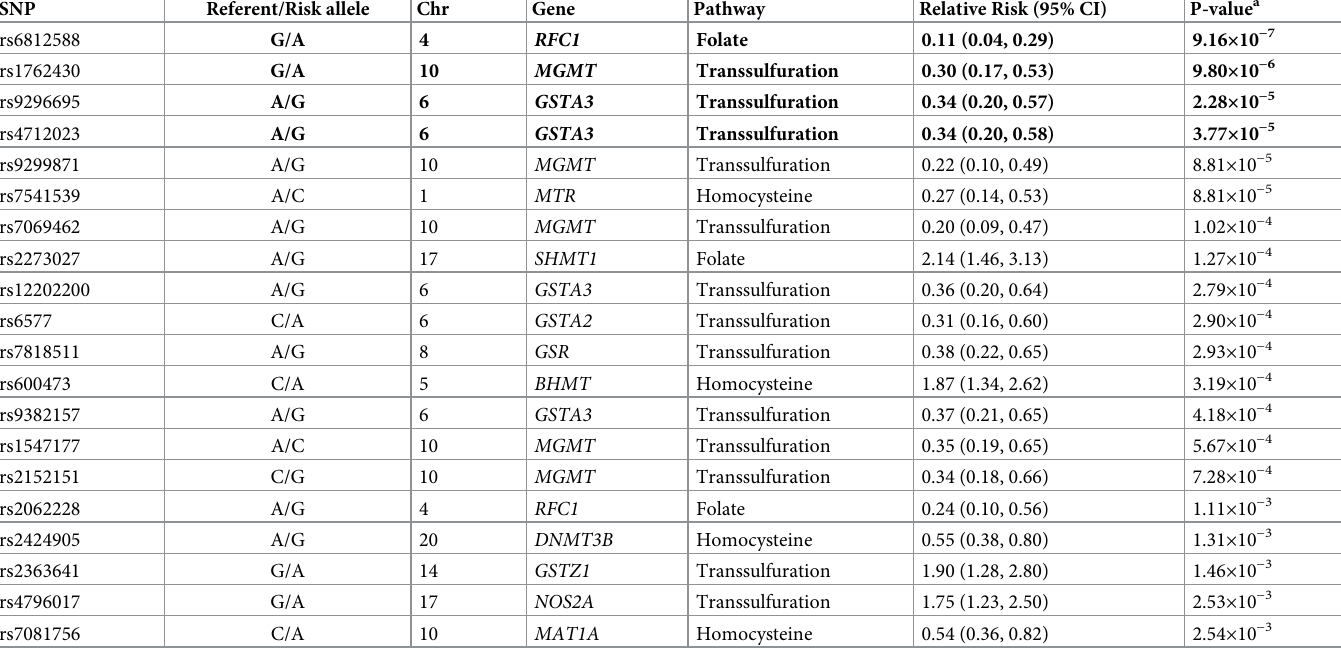
each in replication factor C subunit1 ( RFC1 ) and O-6-methylguanine-DNA methyltransferase ( MGMT ); and two SNPs in glutathione S-transferase alpha 3 ( GSTA3 ). These genes are involved in DNA replication and repair, catalyzing transfer of methyl groups, and cellular defense. Among infants who inherited a paternally-derived copy of the G allele for rs6812588 in the RFC1 gene, the relative risk (RR) of an OHD was 0.11 (95% confidence interval [CI]: 0.04, 0.29, Table 2. Risk ratios and 95% confidence intervals (CIs) with p-values for paternally-derived effects for the top 20 single nucleotide polymorphisms (SNPs) identi- fied from hybrid analyses compared to maternally-derived effects for common variants in genes involved in folate, homocysteine and transsulfuration pathways and risk of obstructive heart defects, The National Birth Defects Prevention Study, USA, October 1997 –August 2008 births (n = 569 case